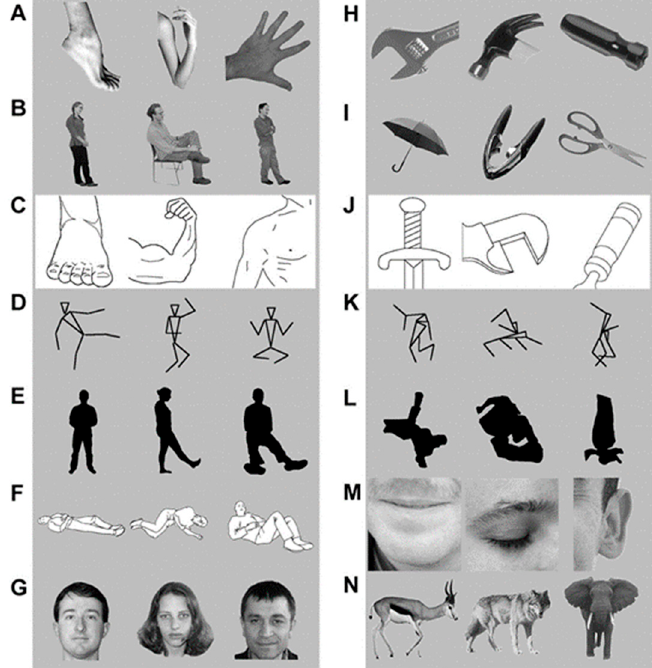
Figure 7. The range of stimuli included in the study, with various depictions of bodies such as body parts ( A ), complete human bodies ( B ), line drawings of body parts ( C ), stick figure ( D ), silhouettes ( E ), and images with inferred motion ( F ). The response was high in all these stimuli as compared to the low response for stimuli H through N. These stimuli are object parts ( H ), complete objects ( I ), line drawings of objects ( J ), scrambled stick figures ( K ), and scrambled silhouettes ( L ). The responses were intermediate for human faces ( G ), face parts ( M ), and mammals ( N ). Panels ( A – N ) adapted with permission from Downing et al. (2001).